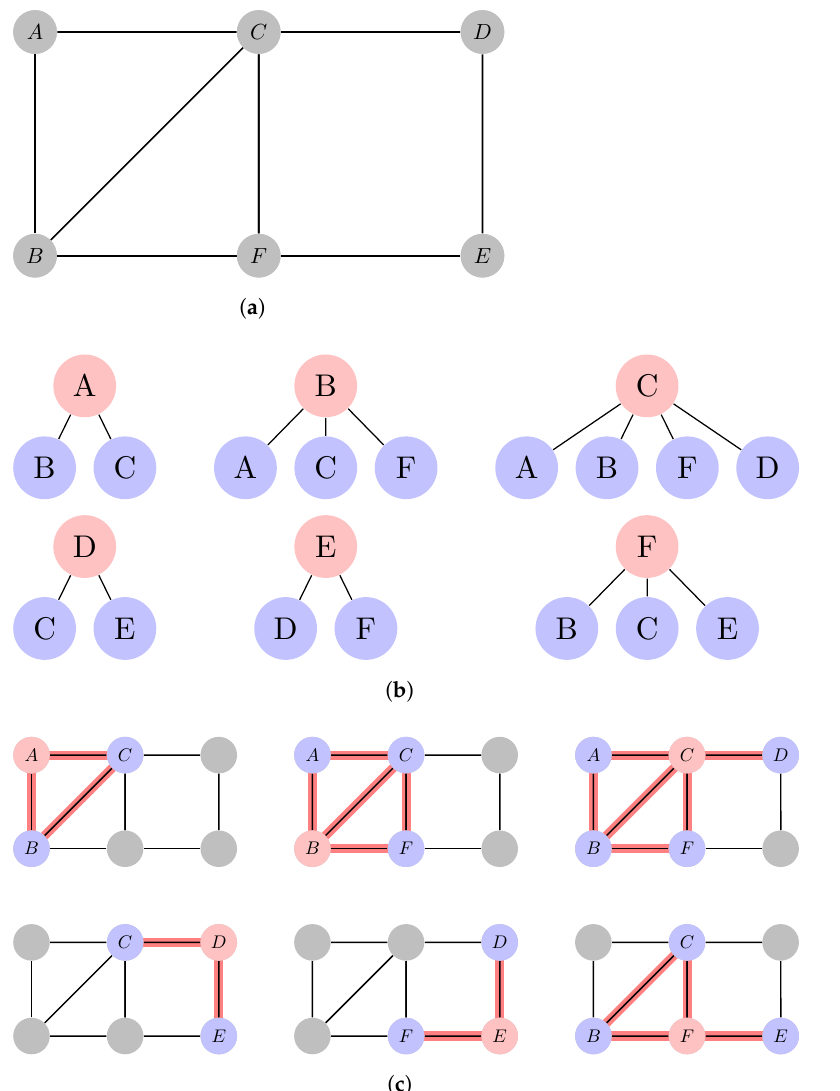
Figure 2. Example of a graph with its rooted trees and rooted subgraphs. The rooted subgraphs incorporate structural information that is lost in rooted trees. MPNNs use rooted trees to update notes. If the features are identical, MPNNs with a single layer will treat nodes B and F as the same; if the network uses the rooted graph instead, it will distinguish B and F . ( a ) A graph with 6 nodes. A , D , and E have degree 2, B and F have degree 3 and F has degree 4. ( b ) Rooted trees with depth 1 for each node. If the nodes have identical features and are not identified, the computational tree of MPNN for A , D , and E are the same. ( c ) Rooted subgraphs with depth 1 for each node. Compared with the routed trees, the A rooted graph is distinguishable from D